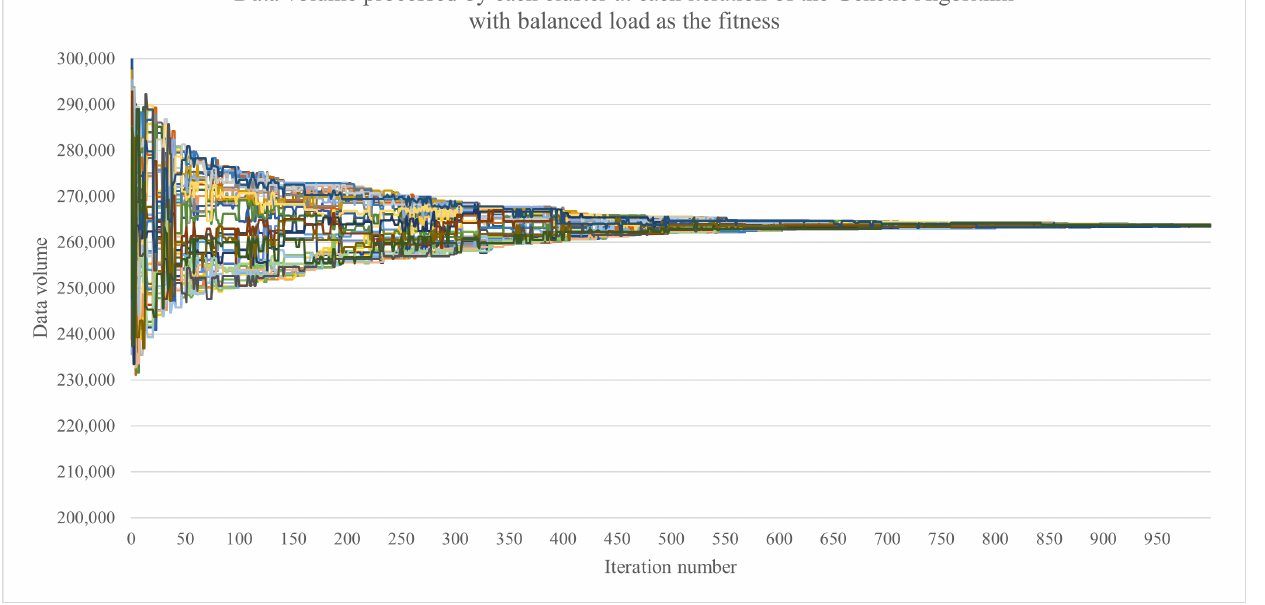
Figure 12. The evolution of the data volume that was assigned to each cluster, represented by the best fit candidate solution at each iteration of the genetic algorithm the load balance as the fitness